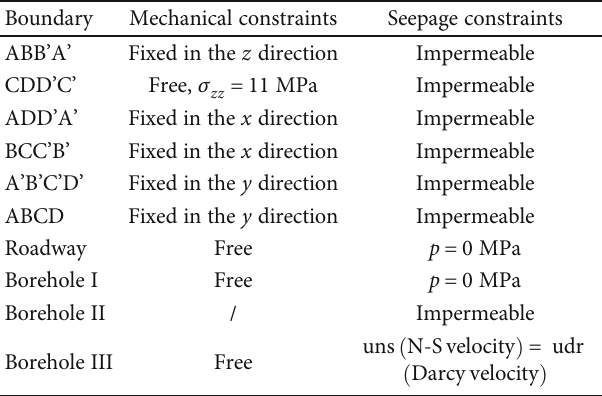
Table 2: Constrain condition of the model.